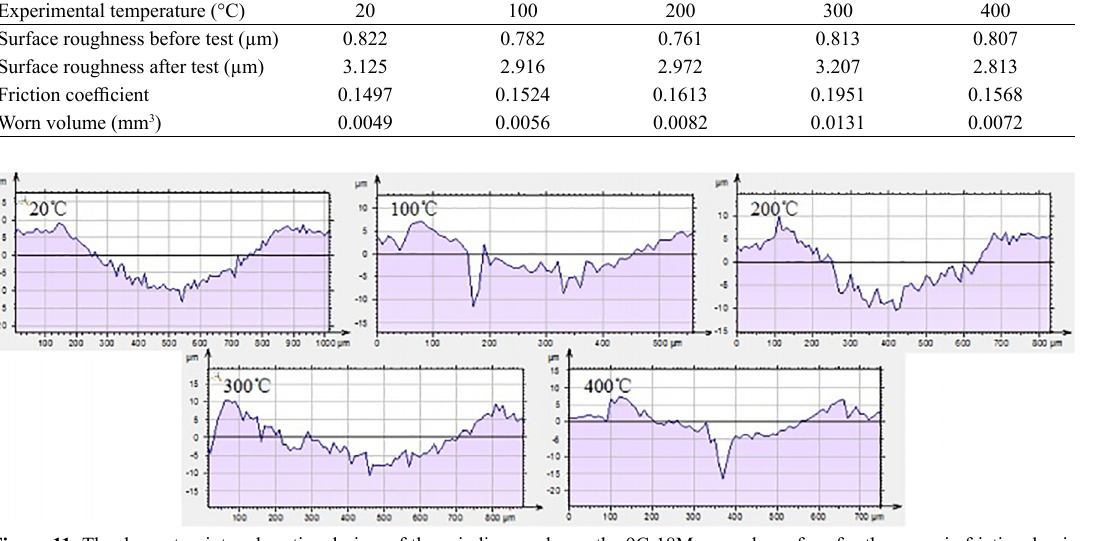
Fig. 12 shows the variation of the friction coefficient and worn volume as functions of temperature for the 9Cr18Mo sample when rubbed by the ceramic frictional pair. By comparison, it can be seen that the high temperature friction and wear properties of the 9Cr18Mo sample are the worst at 300 °C. And the 9Cr18Mo-ceramic frictional pair show good friction and wear behaviors at 400 °C. It is possible that the formation of protective film on the worn surface at 400 °C leads to the decrease of friction